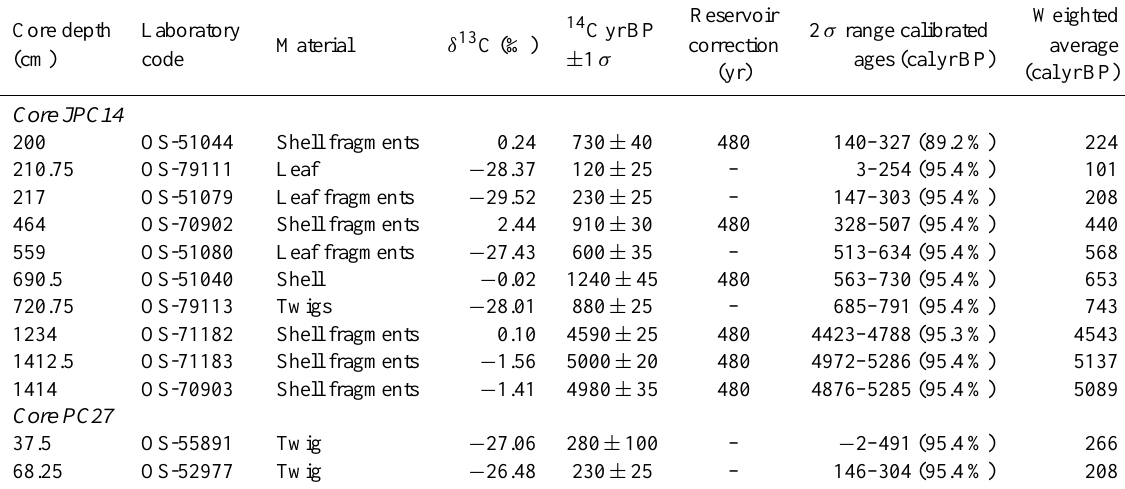
Table 1. Radiocarbon ages obtained on sediment cores JPC14 and